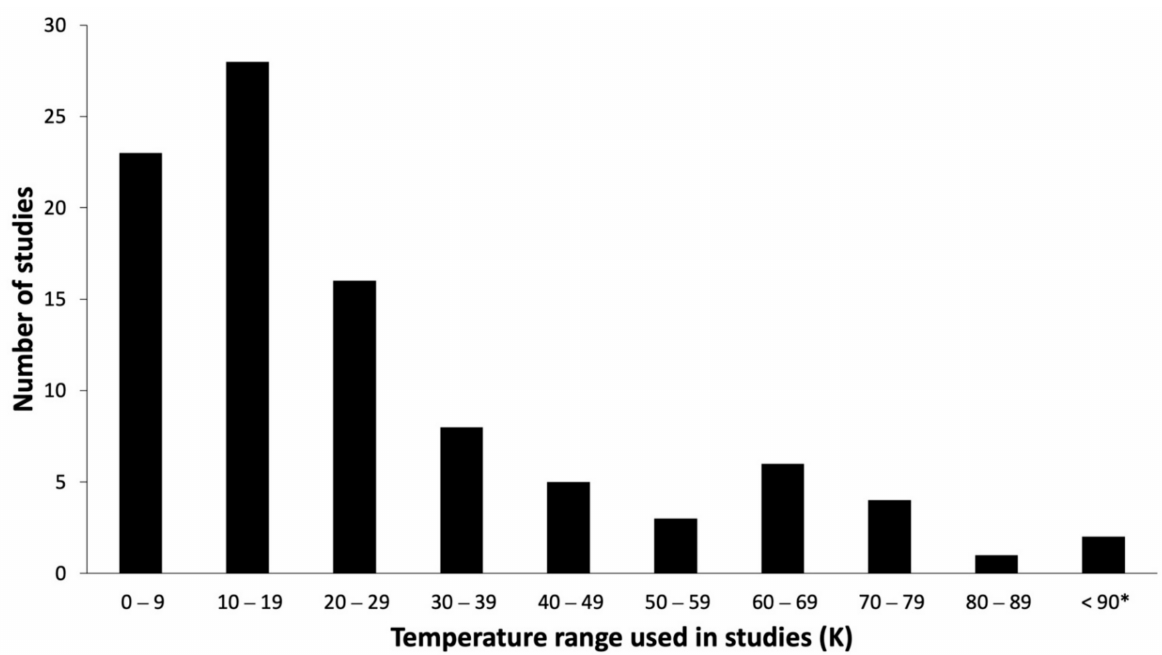
Figure 7. Number of studies binned according to thawing rate, among the studies for which the thawing rate is known.